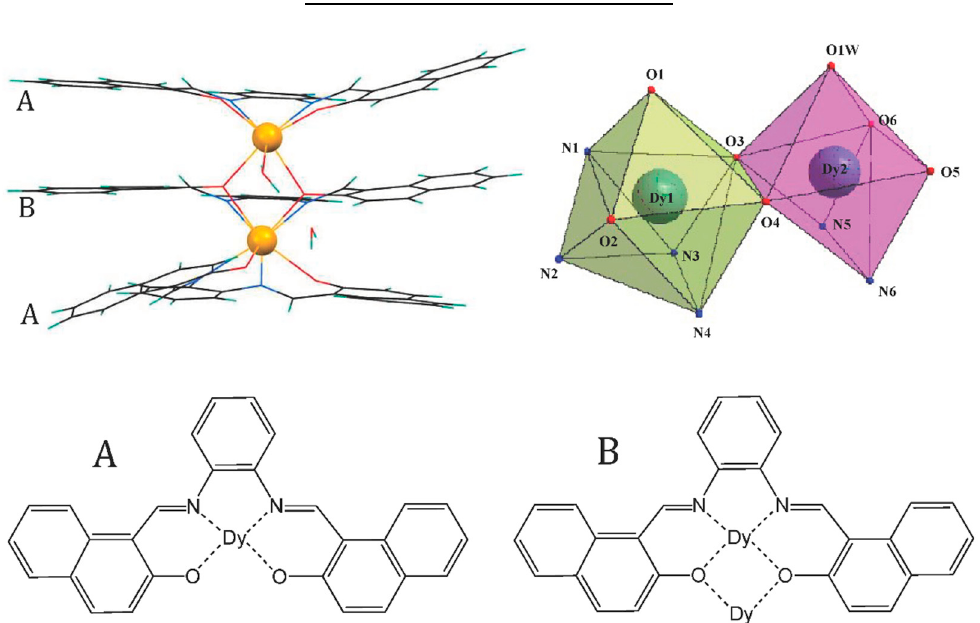
Figure 1. Crystal structure, polyhedral around Dy of SYML-Dy2 and ligand coordination modes A and B , Dy: yellow, O: red, N: blue, C: black and H: green.